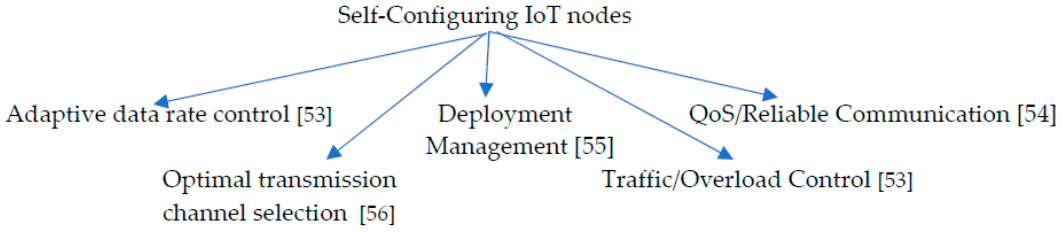
Figure 7. Self-configuration tasks that have benefited from AI integration.